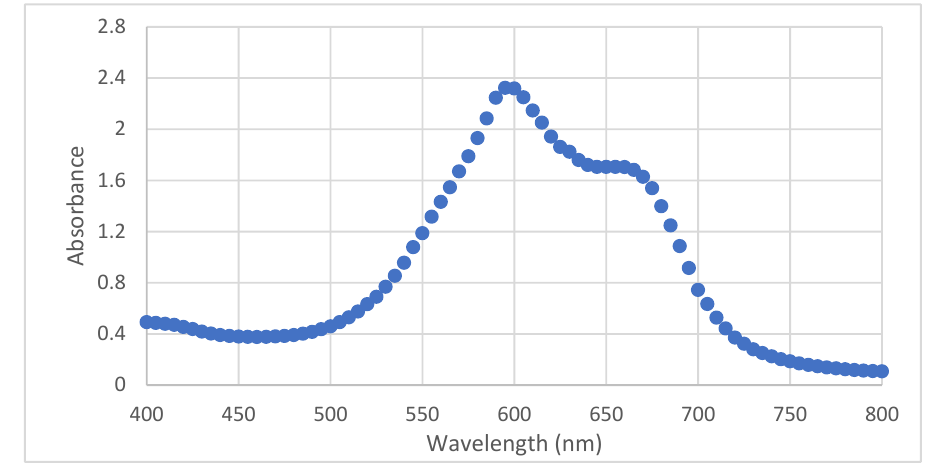
Figure 7. UV – Vis spectrum for derivatives of acetaldehyde. Figure 7. UV–Vis spectrum for derivatives of